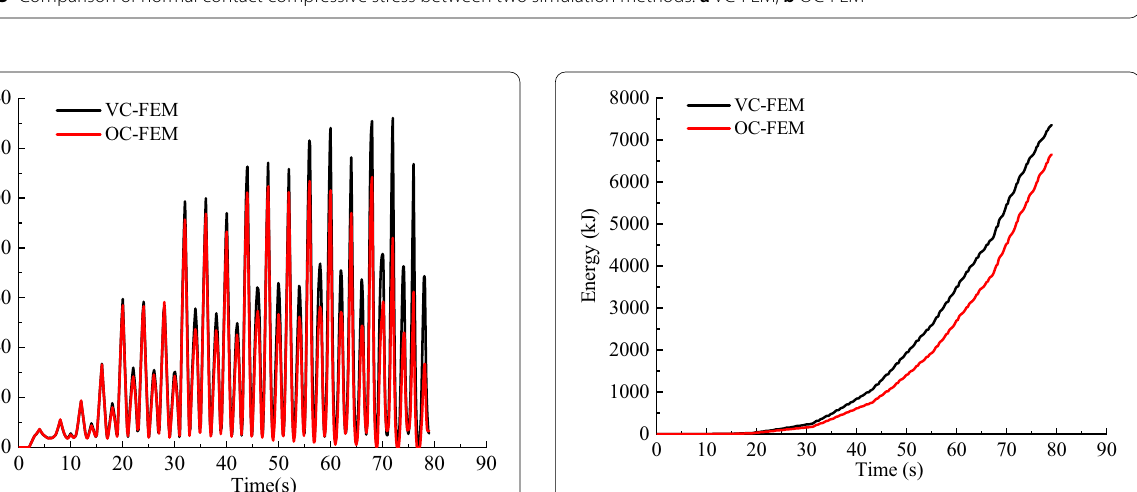
Fig. 33 Comparison of normal contact compressive stress between two simulation methods: a VC-FEM; b OC-FEM